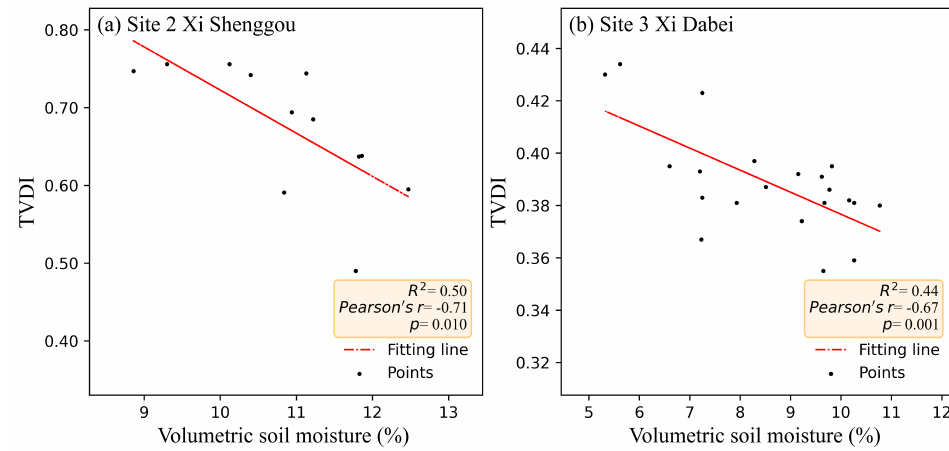
Figure 11. Scatterplots of the soil moisture and TVDI in two flight